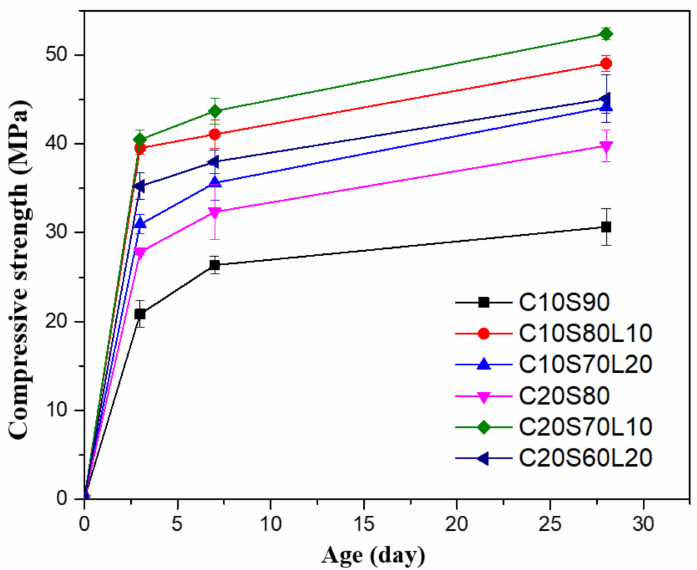
Figure 7. Compressive strength of alkali-activated slag mortar with di ff erent